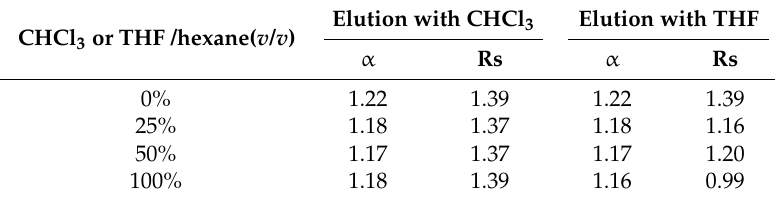
Table 4. Separation of 1-(1-naphthyl) ethanol on CPM2 column after eluting with different contents of mobile phase additives. Elution with CHCl 3 Elution with THF CHCl 3 or THF /hexane( v / v ) α